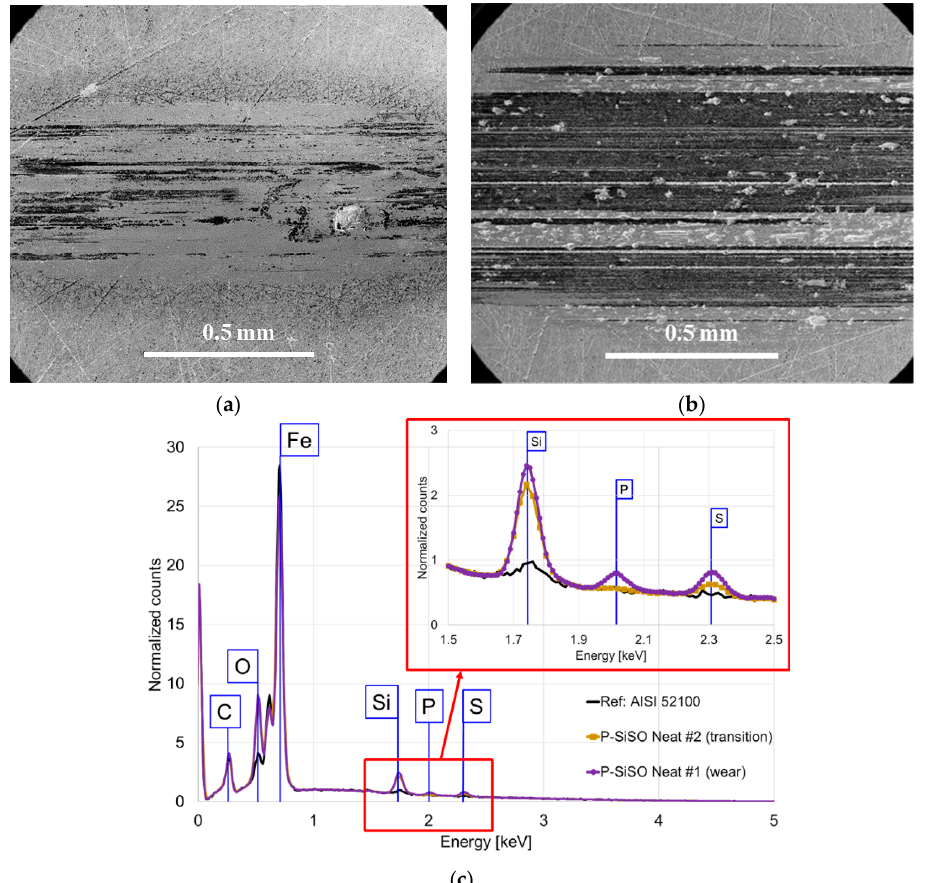
Figure 6. Analysis of disc surfaces from V{300 N/40–80 °C /60 min}. ( a ) and ( b ) display SEM images showing the tribofilms on the wear tracks for tests #2 and #1 respectively. ( c ) EDS spectra of representative regions of the wear scars shown in ( a ) and ( b ).